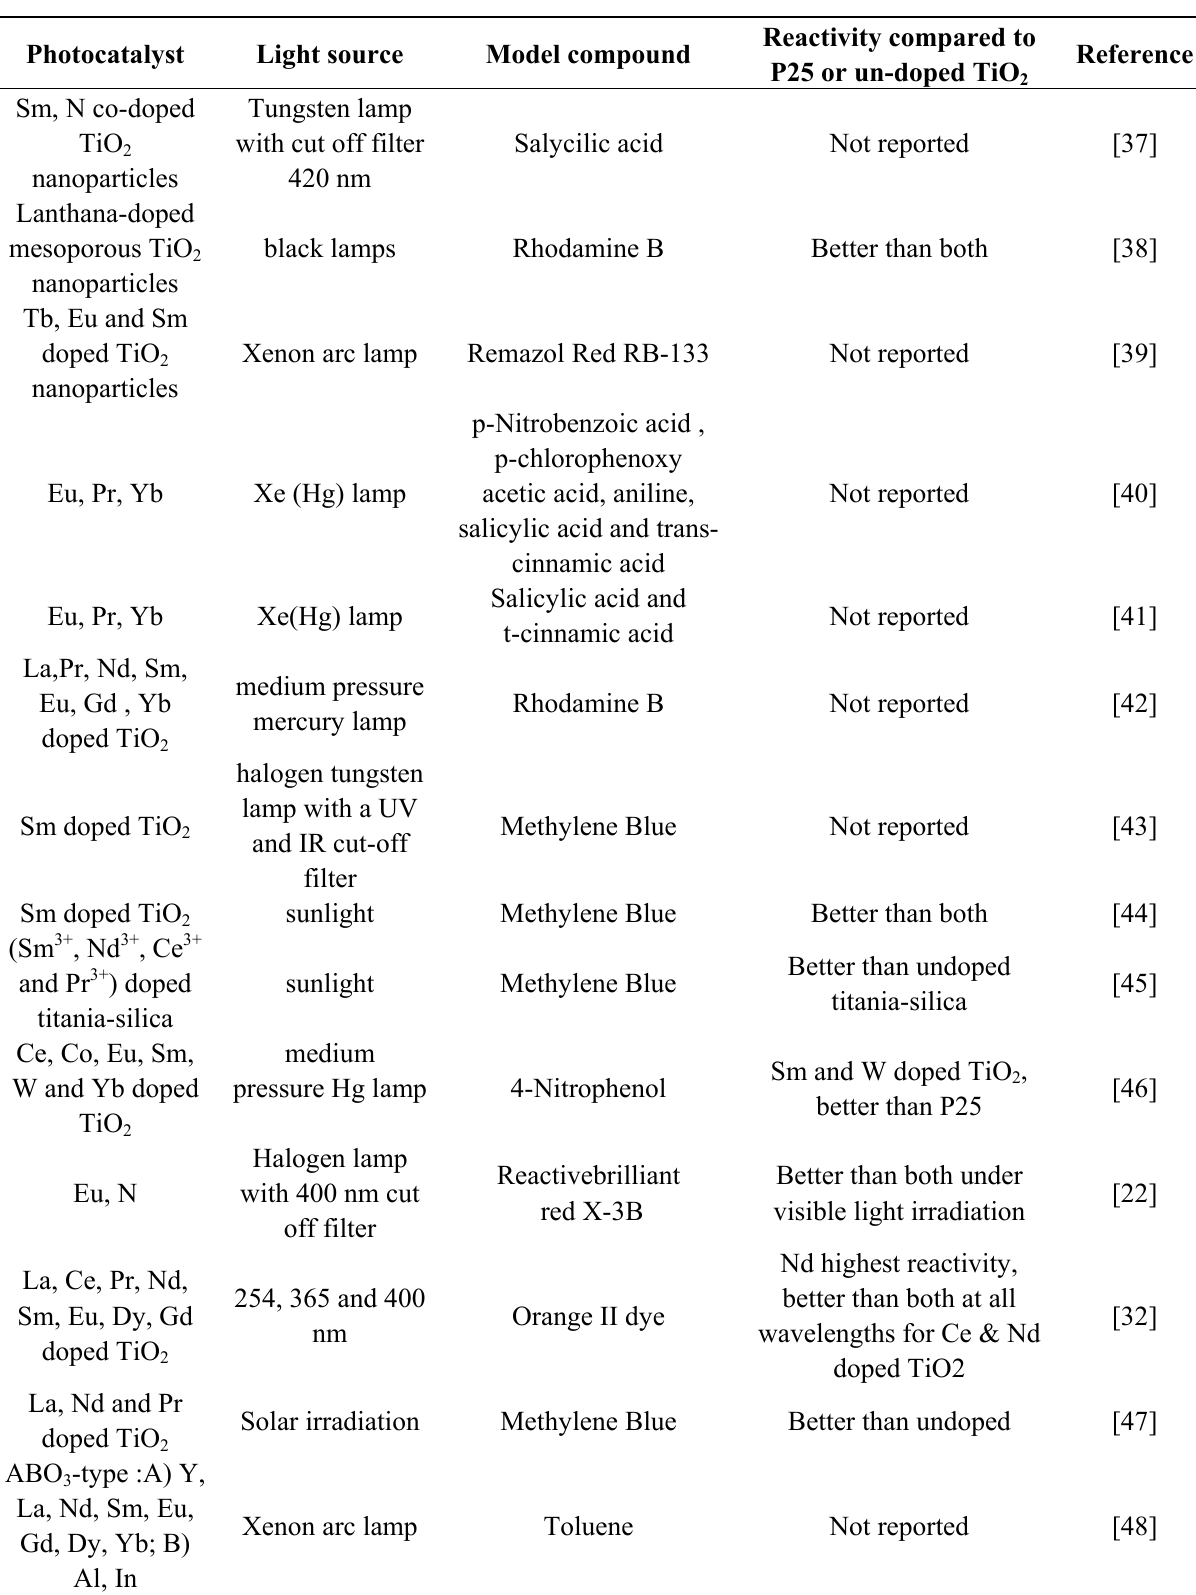
Table A1. Some of the synthesized photocatalysts reported in the literature, chosen model compounds for the reactivity test, light source and their relative reactivities compared to corresponding undoped catalysts and